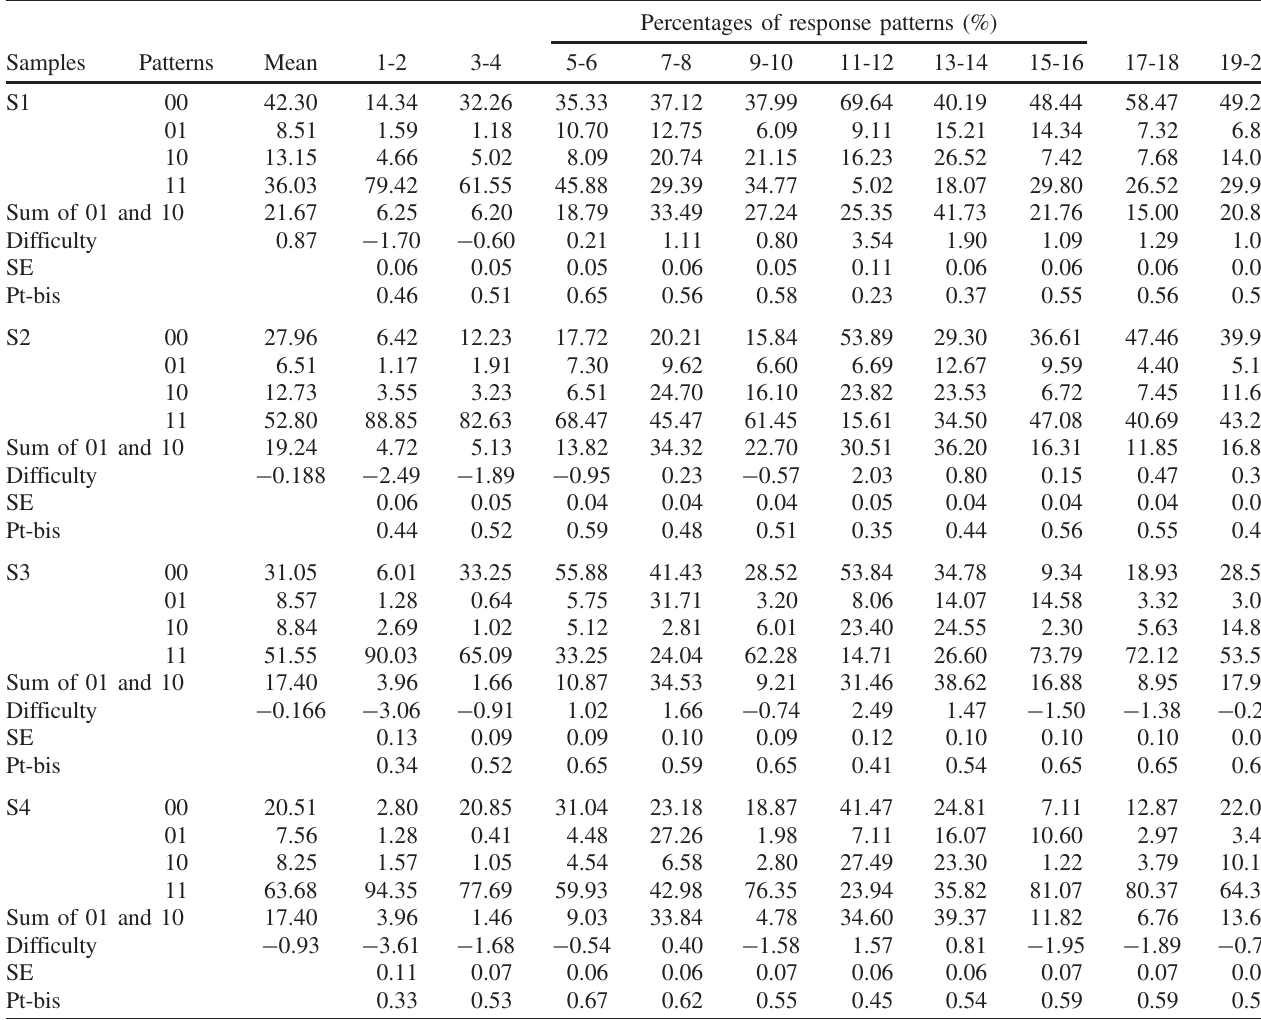
TABLE II. Statistics of students ’ response patterns to items 1 – 20 of the LCTSR.